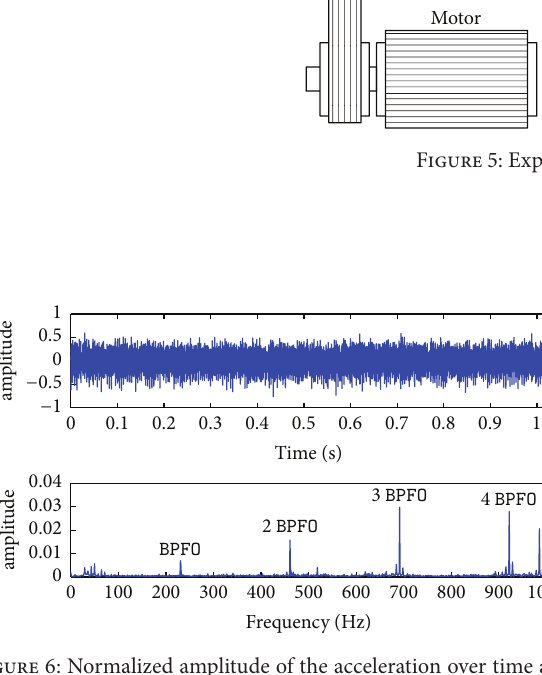
Figure 6: Normalized amplitude of the acceleration over time and frequency domains for the 900th data sample on accelerometer 1 .